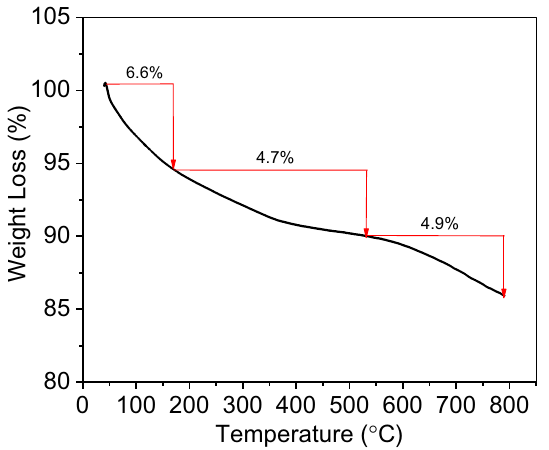
Figure 9. Thermal stability behavior of FGS2 by TGA